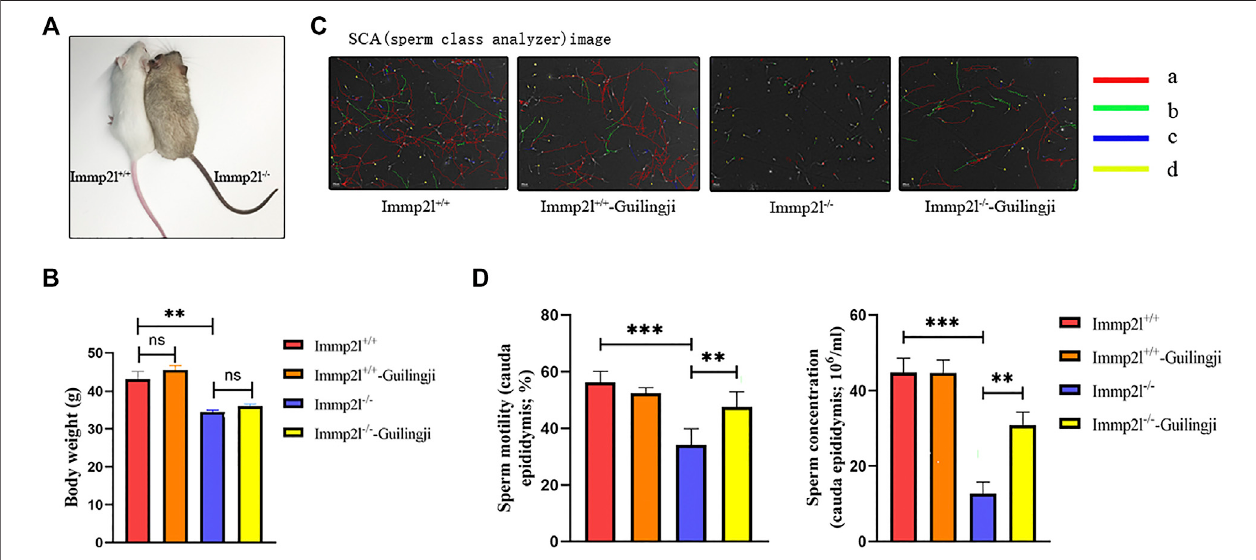
FIGURE1| Immp2lmutantmiceandspermqualityanalysis. (A) Homozygousmutantmiceweredarklypigmented(right). (B) Thein fl uenceofGuilingjitreatmenton body weight of Immp2l − / − and Immp2l +/+ mice. (C) The sperm concentration and motility were measured by a computer-aided sperm analysis system. (D) The analysis of sperm concentration and motility. mean ± SEM. ns, Not signi fi cant. ** and ***, p < 0.01 and p < 0.001. n (cid:1)